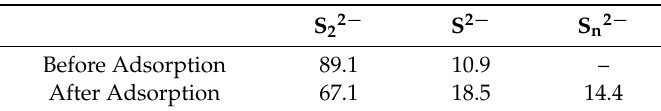
Table 7. Atomic concentrations (%) of different sulfur species on pyrite (1 0 0) surface before and after adsorption of